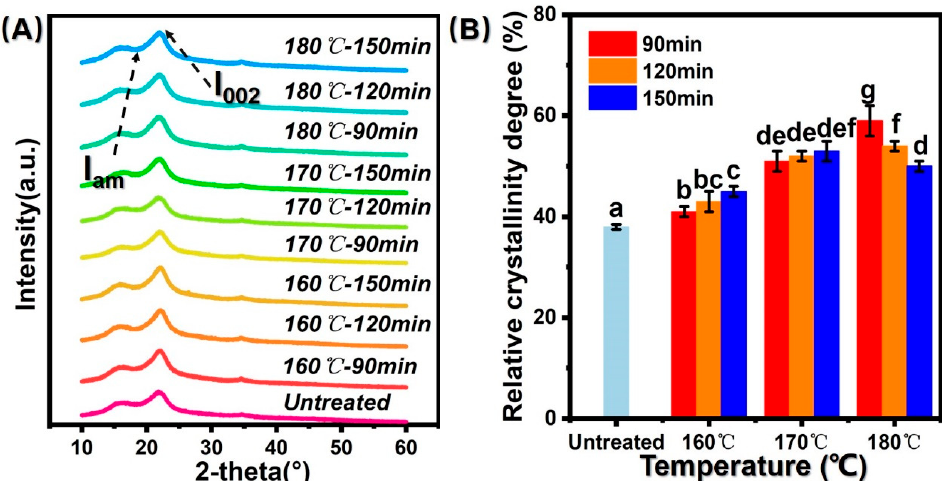
Figure 4. ( A ) XRD diagrams of bamboo cell walls. ( B ) Relative crystallinity degree of bamboo specimens. The different letters represent significant differences between treatments ( p < 0.05).